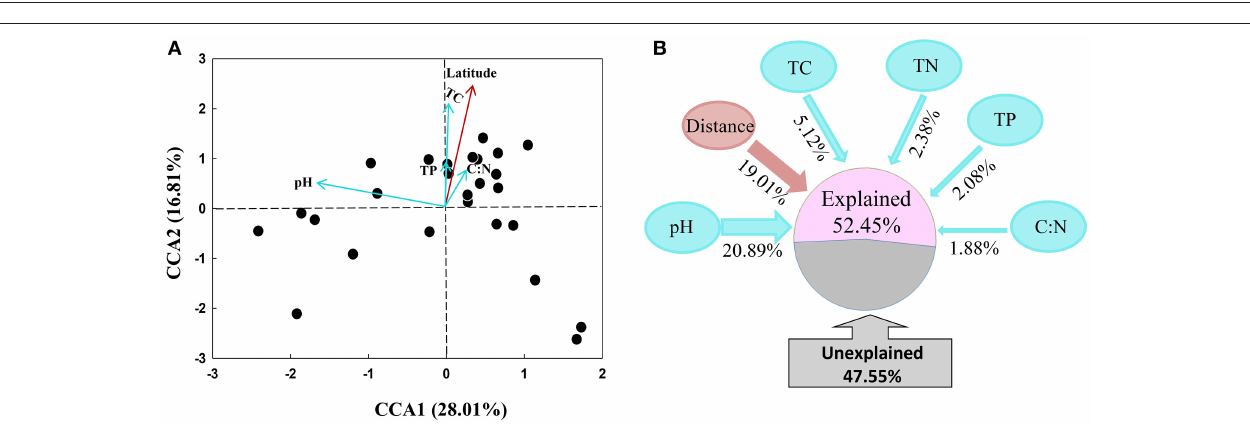
FIGURE 3 | Archaeal community compositions in the black soils, as indicated by non-metric multi-dimensional scaling plots of weighted pairwise UniFrac community distances between sites. Sites are color-coded to soil pH gradient (A) and soil total carbon gradient (B) .